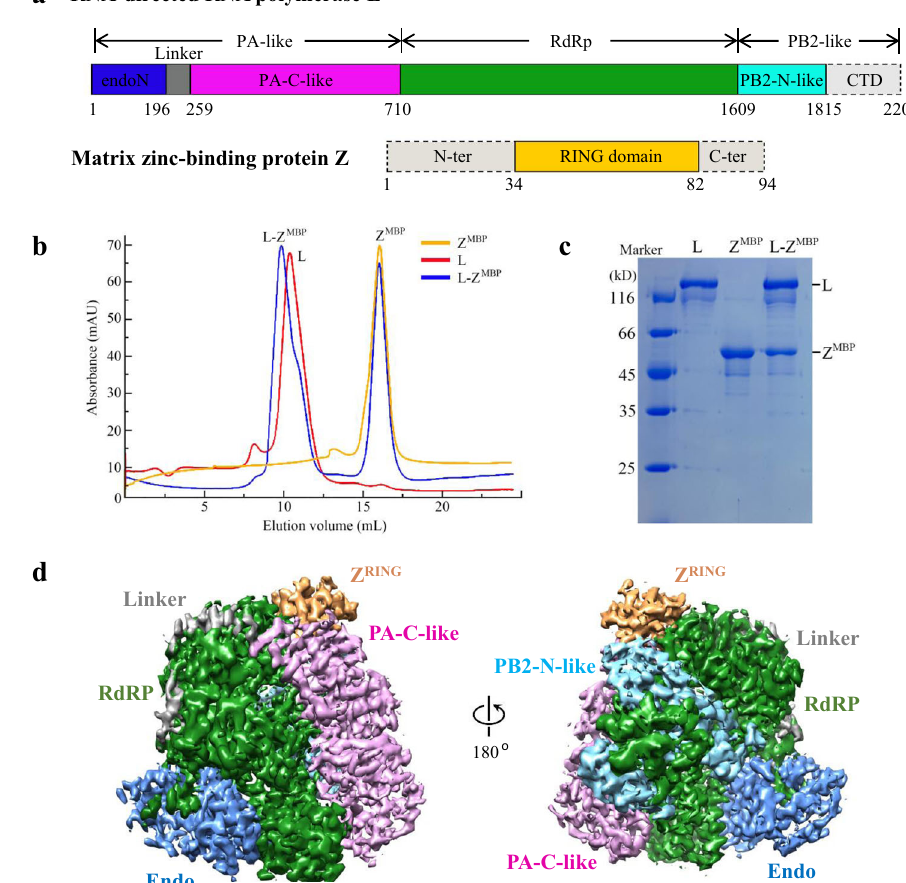
Fig. 1 Structure determination of the MACV L – Z complex by cryo-EM. a Schematic diagram of the domain structure of the MACV L and Z proteins. The endoN domain, linker, PA-C-like domain, RdRp, PB2-N-like domain of L are showed in slate, gray, pink, smudge and cyan, respectively, while the solved RING domain of Z colored orange and unresolved regions represented by gray with dotted outlines. The interdomain borders of each protein are labeled with residue numbers. b and c Gel fi ltration analysis ( b ) and coomassie-stained SDS – PAGE ( c ) of the L protein, monomeric MBP-Z fusion protein and L – Z MBP complex. Molecular weights (in kilodaltons) of marker are shown on the left, and bands are labeled on the upper and right. The data shown are representative results of more than two independent experiments. d Cryo-EM density map of the L – Z monomeric complex determined at 4.0 Å resolution in two orientations. The density map is assembled from the individual domains of L and the RING domain of Z, indicated and colored as in ( a